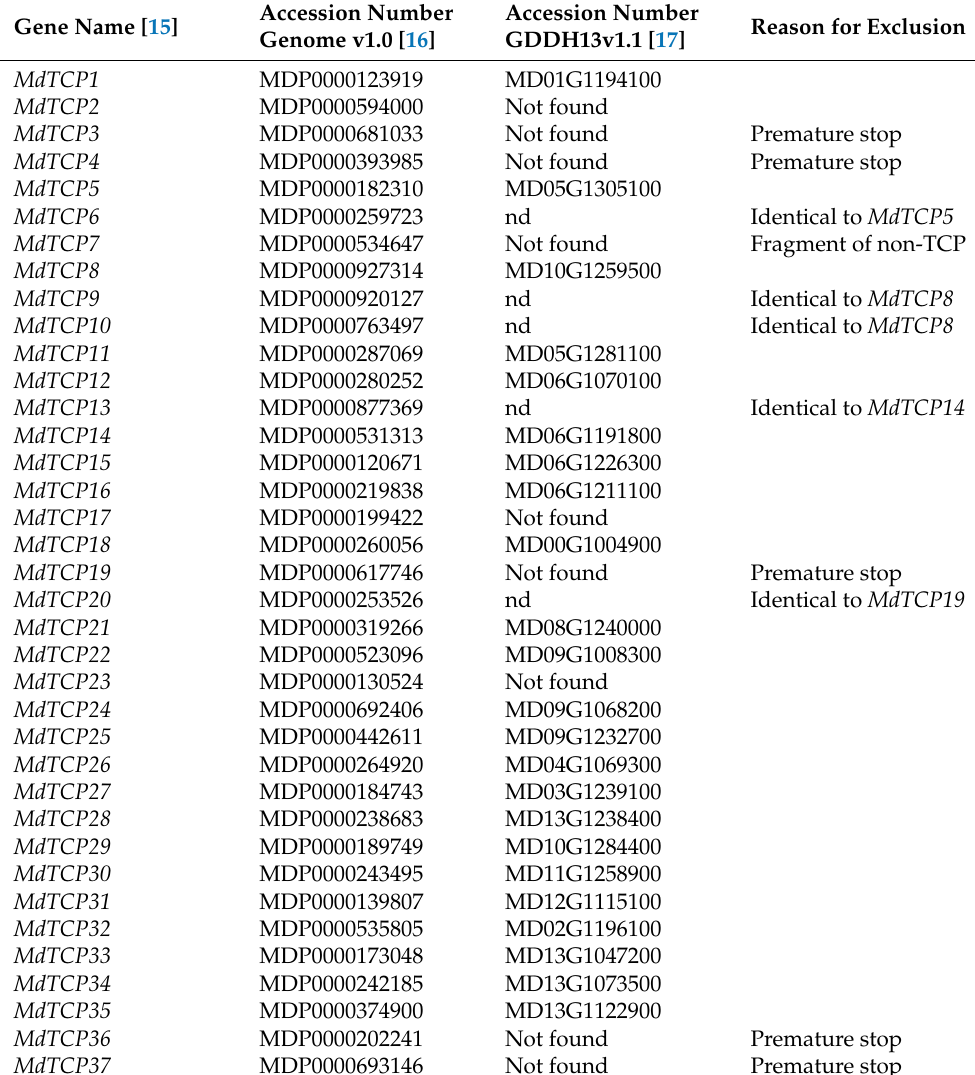
Table 1. MdTCP genes identified by Xu et al. [15] and relative accession numbers determined on the 2010 genome assembly [16] and in the present work on the most recent genome assembly GDDH13v1.1 (IRHS database; https://iris.angers.inra.fr/gddh13/; accessed 19 January 2022) [17]. From this original set, six sequences were excluded due to redundancy with other sequences, seven due to the presence of premature stop codons and two for constituting fragments of non-TCP genes. A new GDDH13v1.1 accession was successfully determined for 33 MdTCPs , while for four